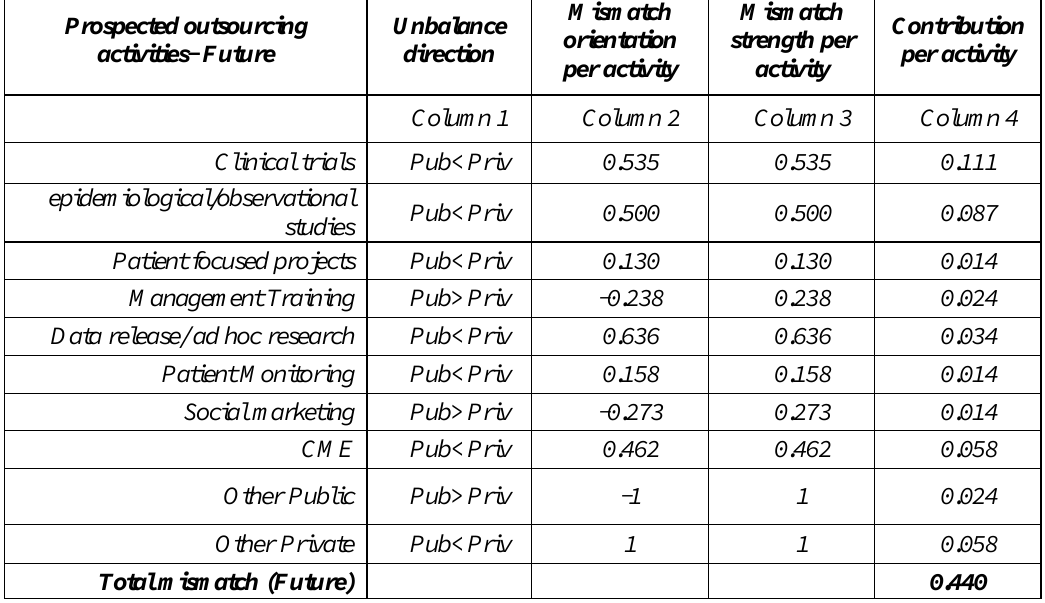
Table 2 : Mismatch Value per Prospected Outsourcing Activities.